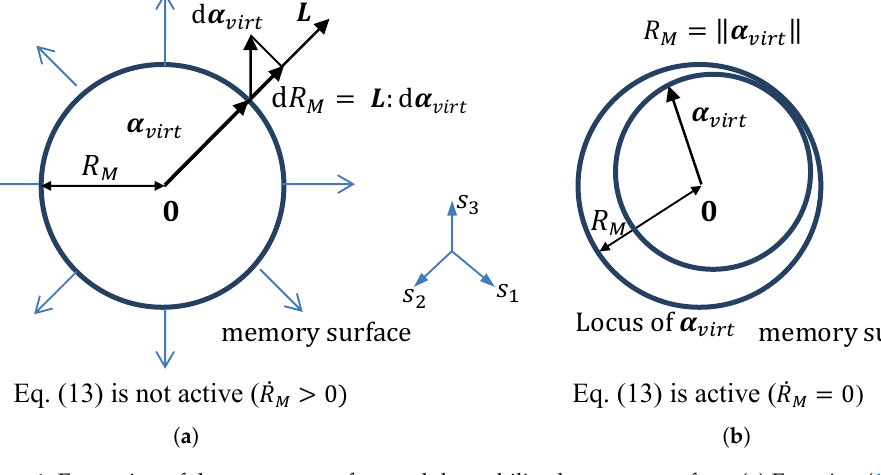
Figure 1. Expansion of the memory surface and the stabilized memory surface. ( a ) Equation (13) is not active; ( b ) Equation (13) is